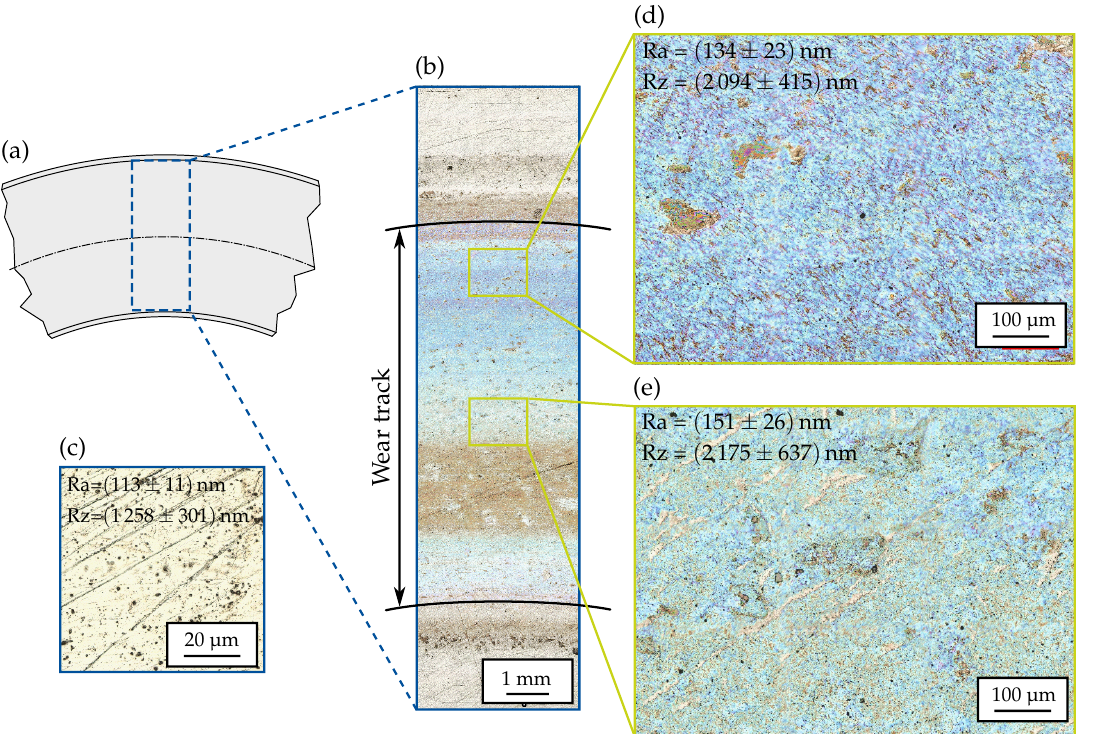
Figure 6. Damage analysis of a MoO 3 specimen by 3D laser scanning microscope: ( a ) Principal section view of a bearing washer (schematic). ( b ) Overview of the wear track after a test duration of 48h. ( c ) Bearing washer in initial state with measured roughness parameters Ra and Rz. ( d , e ) High resolution microscopic view of the wear area with Ra and